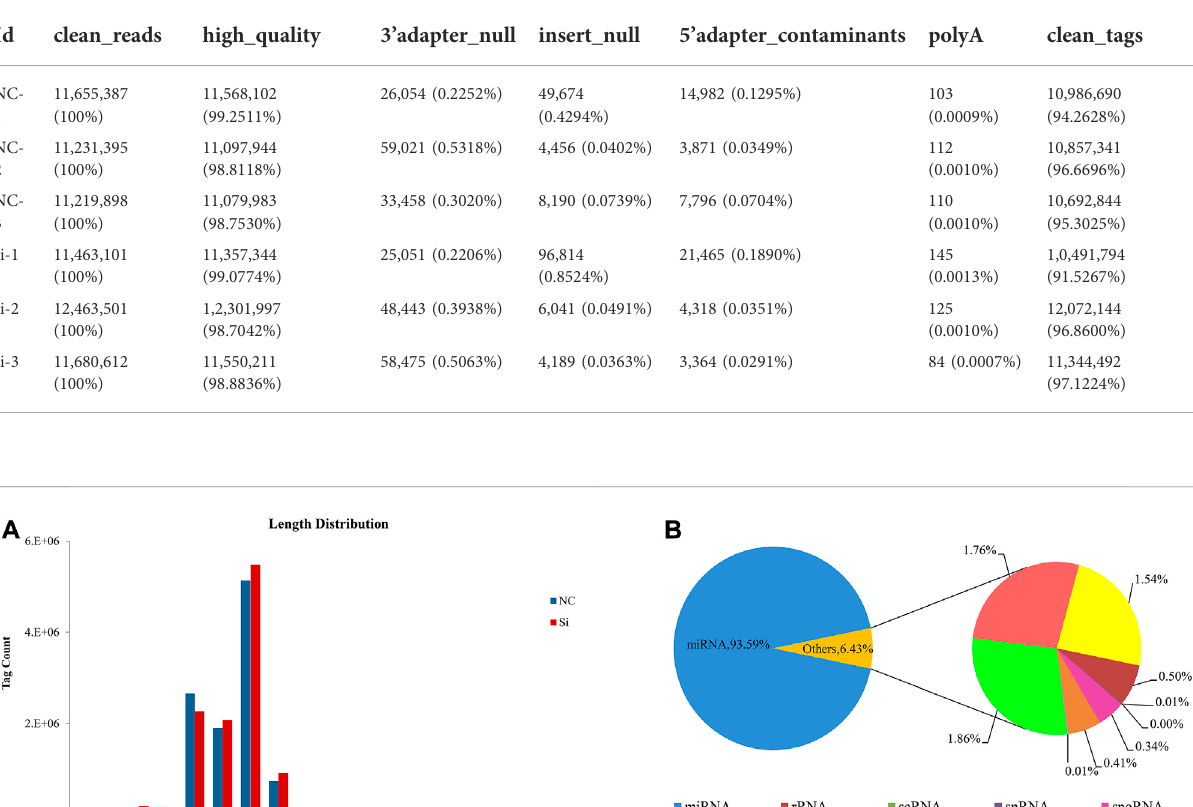
TABLE 1 Overview of small RNA sequencing.